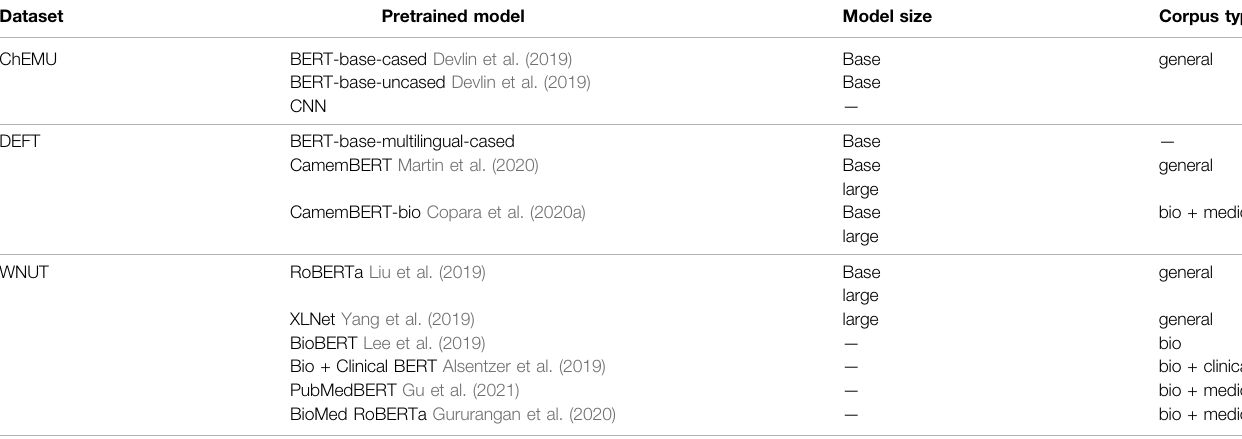
TABLE 4 | Pretrained models used for NER in the ChEMU, DEFT, and WNUT benchmark datasets. Dataset